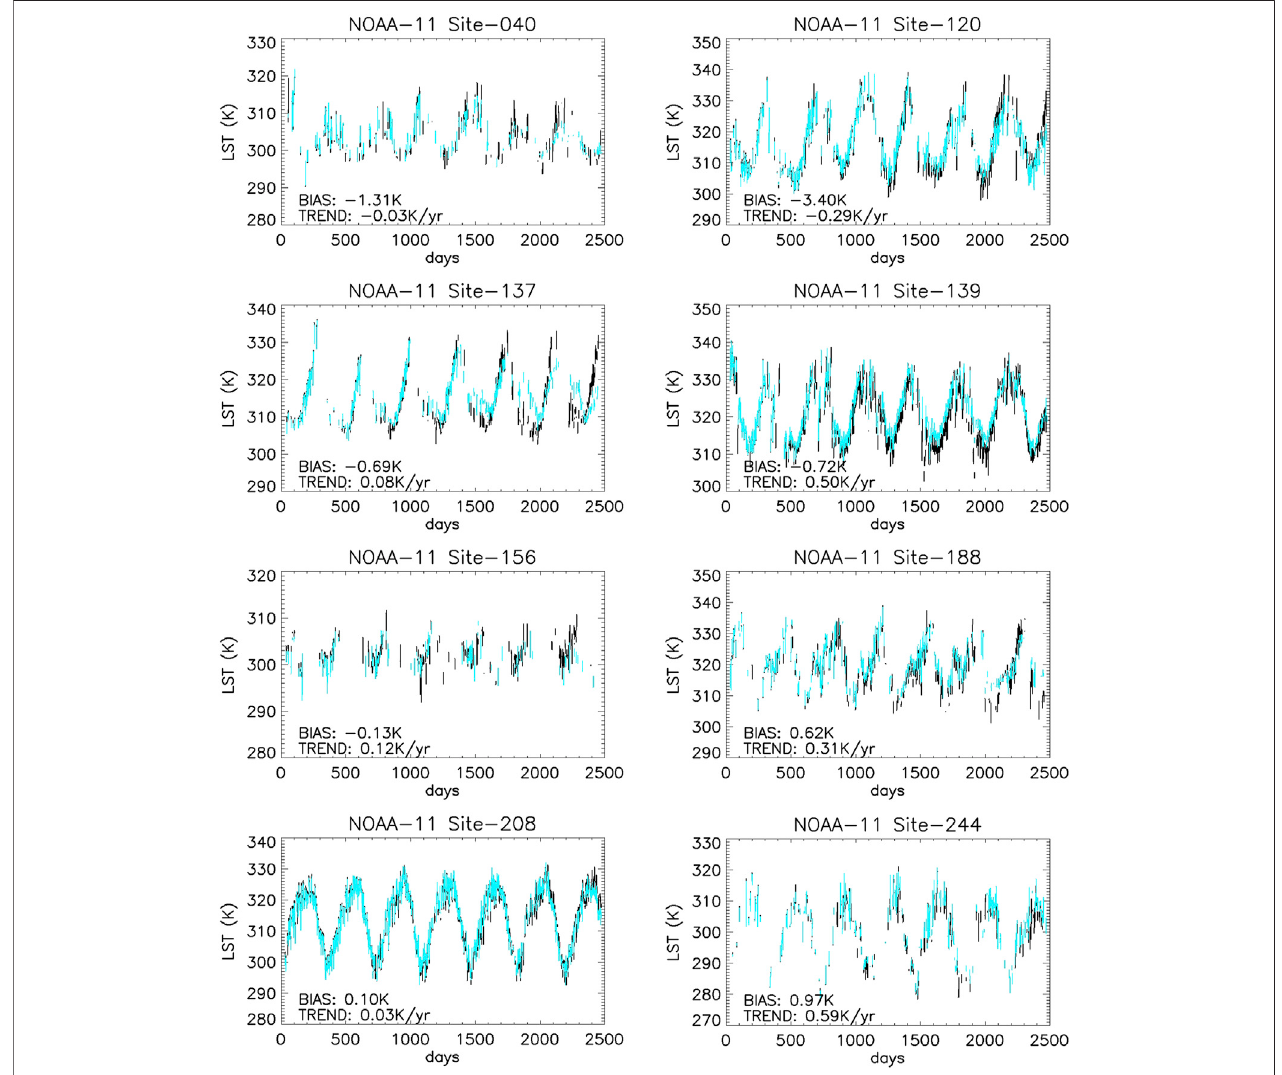
FIGURE6| Corrected timeseriesforNOAA-11 platform foreightselectedsites: reference(black) andrealcasecorrected(blue) timeseriesalongwiththeresulting bias and trend difference statistics.